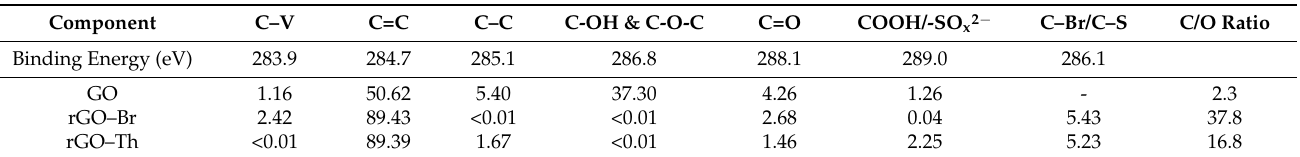
Table 1. Composition of functional groups (at.%) and C/O ratio in GO, rGO–Br, and rGO–Th derived from the processed C 1 s